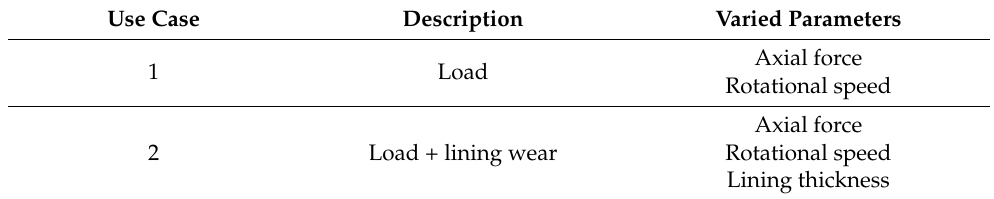
Table 1. Description of the two use cases with the corresponding examined parameters.